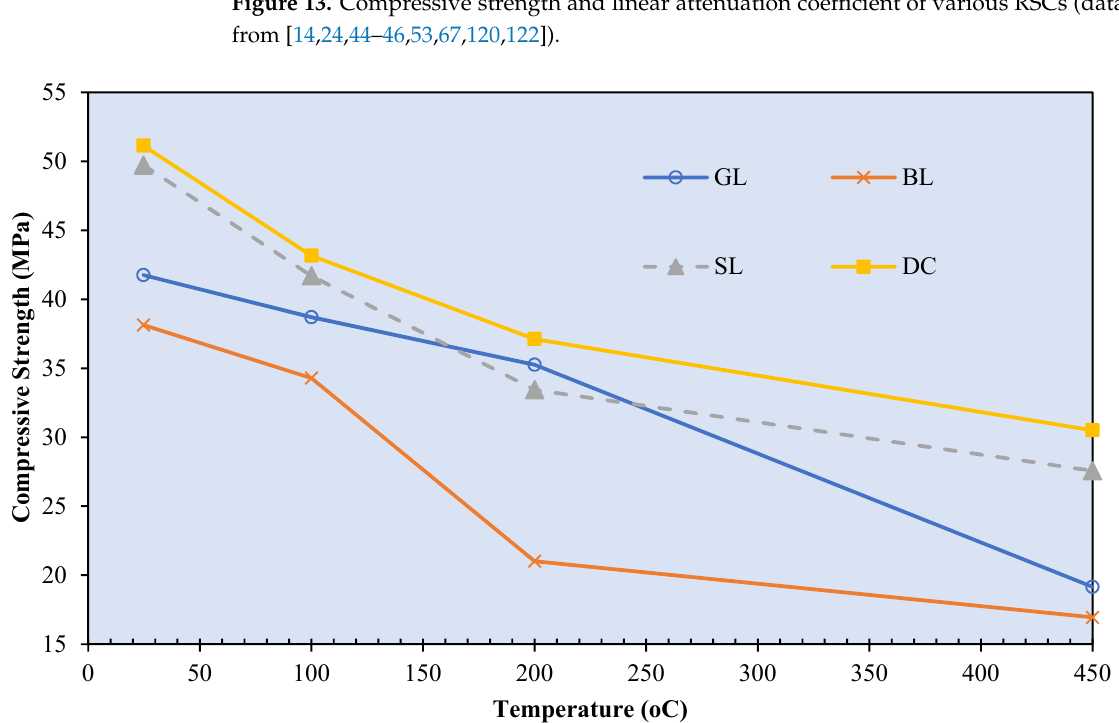
Figure 14. Compressive strength for preheated and unheated concrete at varying temperatures (adapted from [67]).